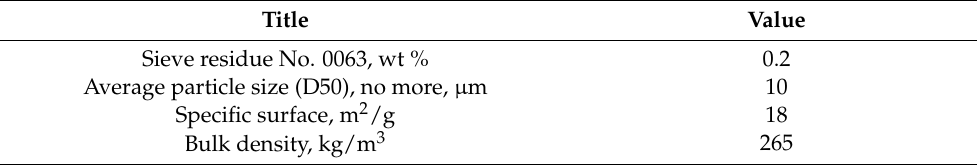
Table 3. Physical characteristics of metakaolin.